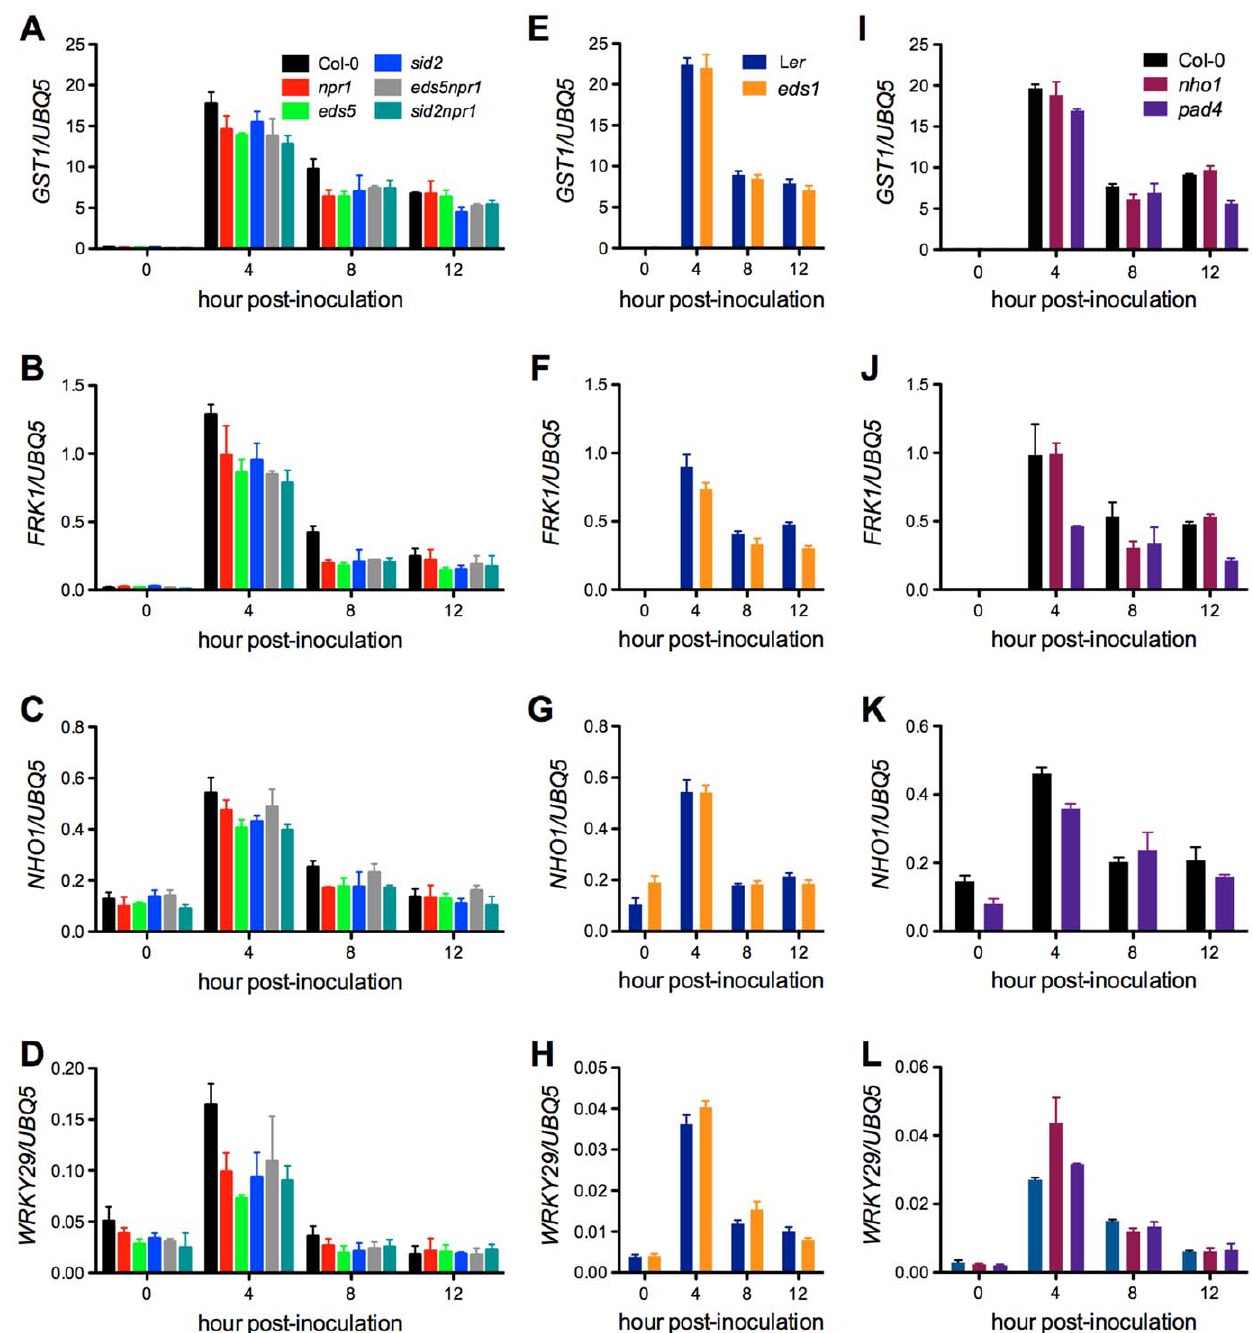
Figure 8. Expression of early response genes in the Xcc susceptible mutants. ( A to D ) Expression of GST1 , FRK1 , NHO1 , and WRKY29 in npr1 , eds5 , sid2 , eds5npr1 , and sid2npr1 . ( E to H ) Expression of GST1 , FRK1 , NHO1 , and WRKY29 in eds1 . ( I to L ) Expression of GST1 , FRK1 , NHO1 , and WRKY29 in nho1 and pad4 . Four-week-old plants were inoculated with Xcc (OD 600 =0.02). Leaf tissues were collected at different time points (0, 4, 8, and 12 hpi) for total RNA isolation and gene expression analysis using RT-qPCR. Expression levels were normalized against constitutively expressed UBQ5 . Data represent the mean of three biological replicates with standard deviation. Mutant eds1 is in L er genetic background, whereas others ( nho1 , eds5 , pad4 , sid2 , npr1 , eds5npr1 , and sid2npr1 ) are in Col-0 genetic background. The experiment was repeated twice with similar results.